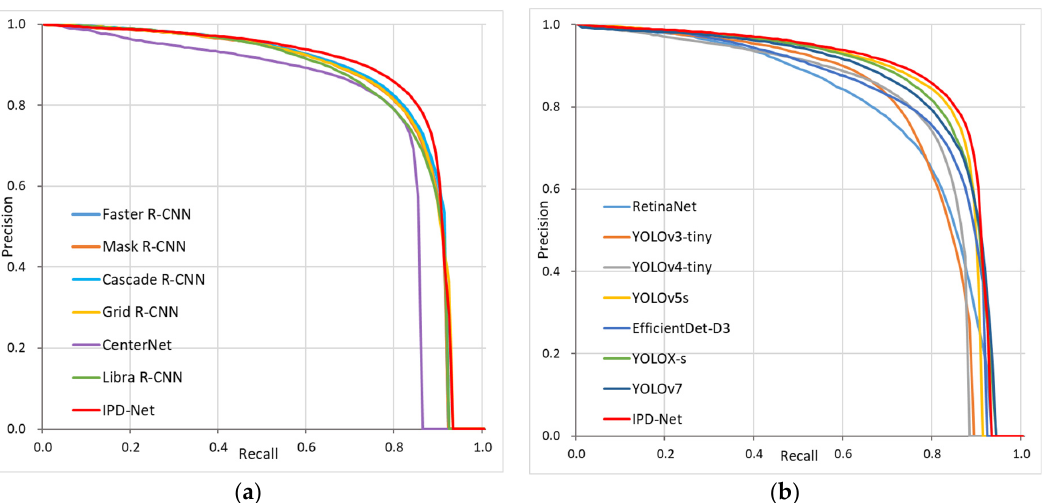
Figure 10. Precision–recall curves for IPD-Net and mainstream target detection algorithms: ( a ) two- stage algorithms; ( b ) one-stage algorithms.